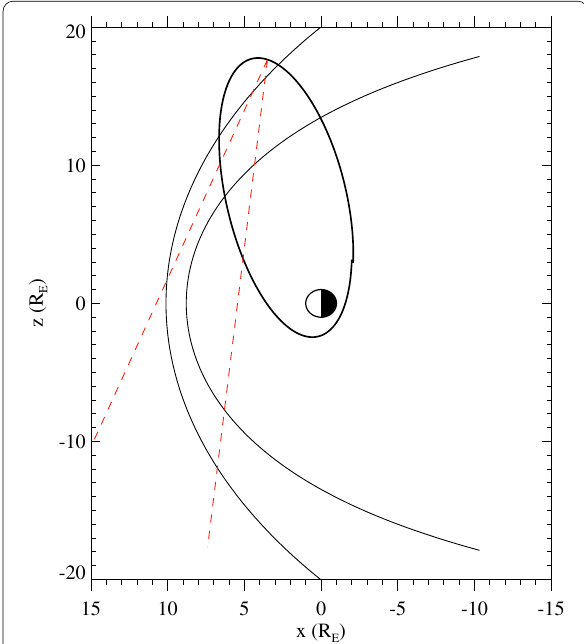
Fig. 1 The SMILE orbit. A sketch of the orbital and viewing geometry of the Solar wind Magnetosphere Ionosphere Link Explorer (SMILE) mission. The coordinates are in Earth radii. The x-axis points toward the Sun in the left. The black thick ellipse is a example of an orbit, black thin lines depict the magnetopause and bow